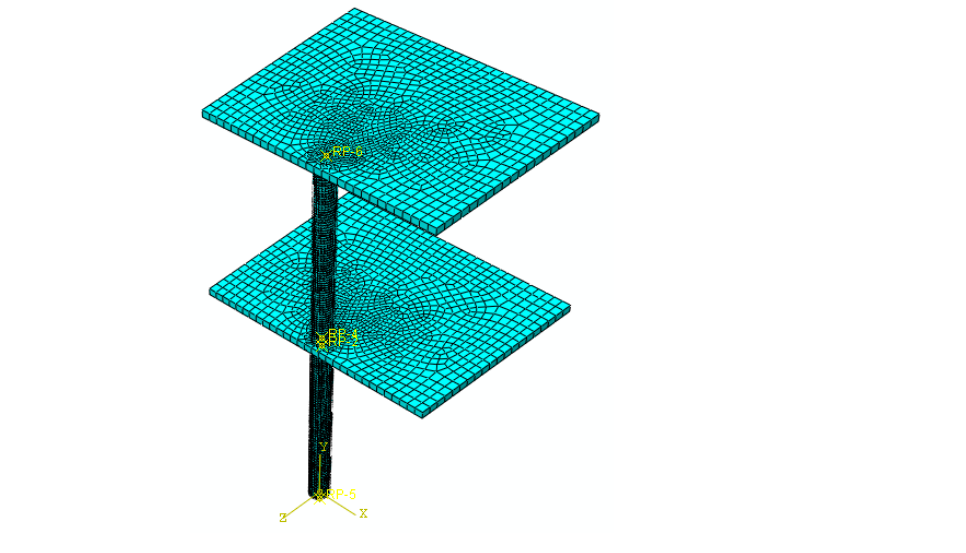
Figure 24. Mesh density of the finite element model.